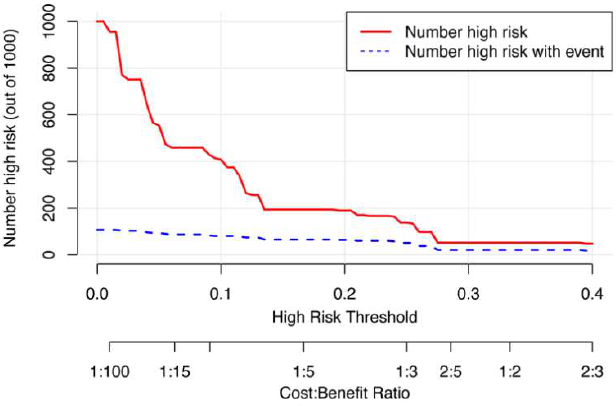
Figure 6. The clinical impact curves of the nomogram prediction model.